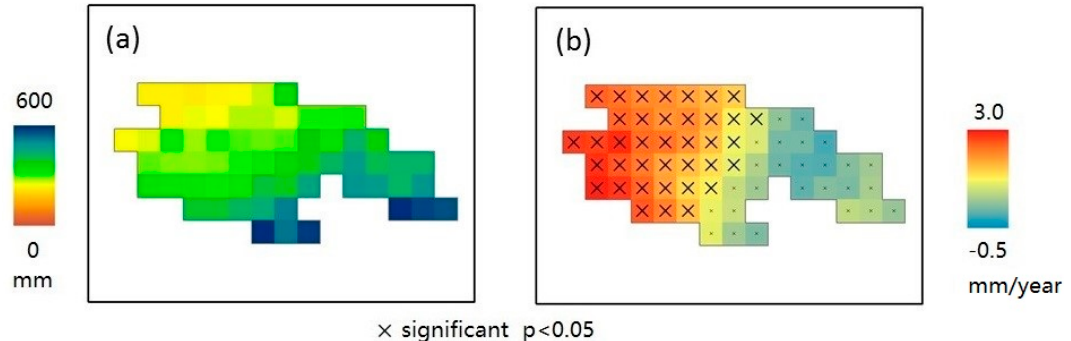
Figure 3. ( a ) Mean annual precipitation in the source region of the Yangtze River; ( b ) trend in mm per year.